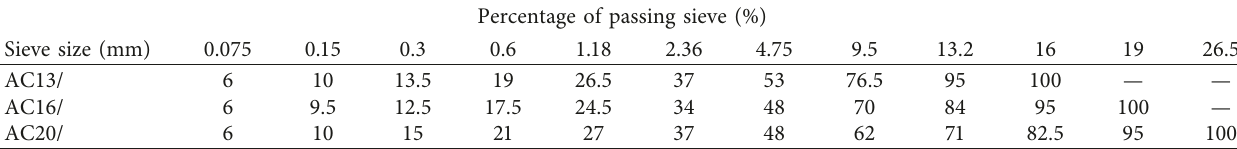
Table 3: Gradation composition of aggregates.